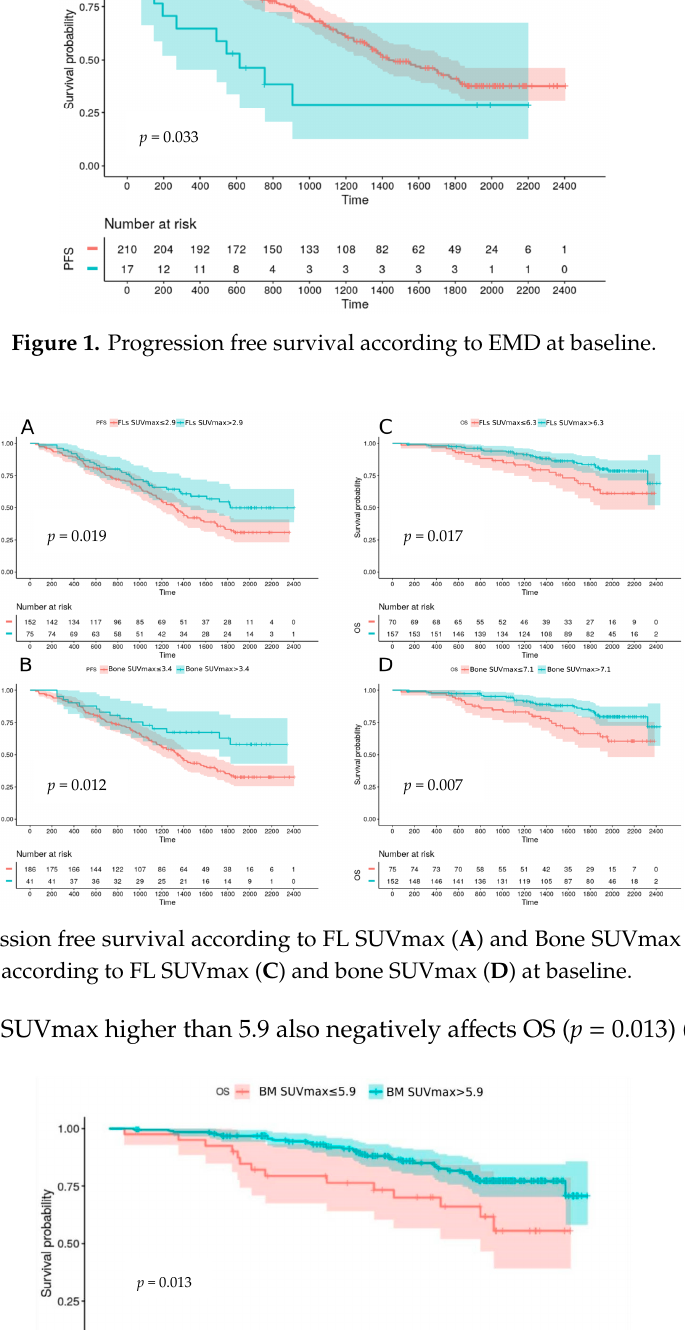
Table 3. Univariate and multivariate analysis of baseline variables on PFS and OS .